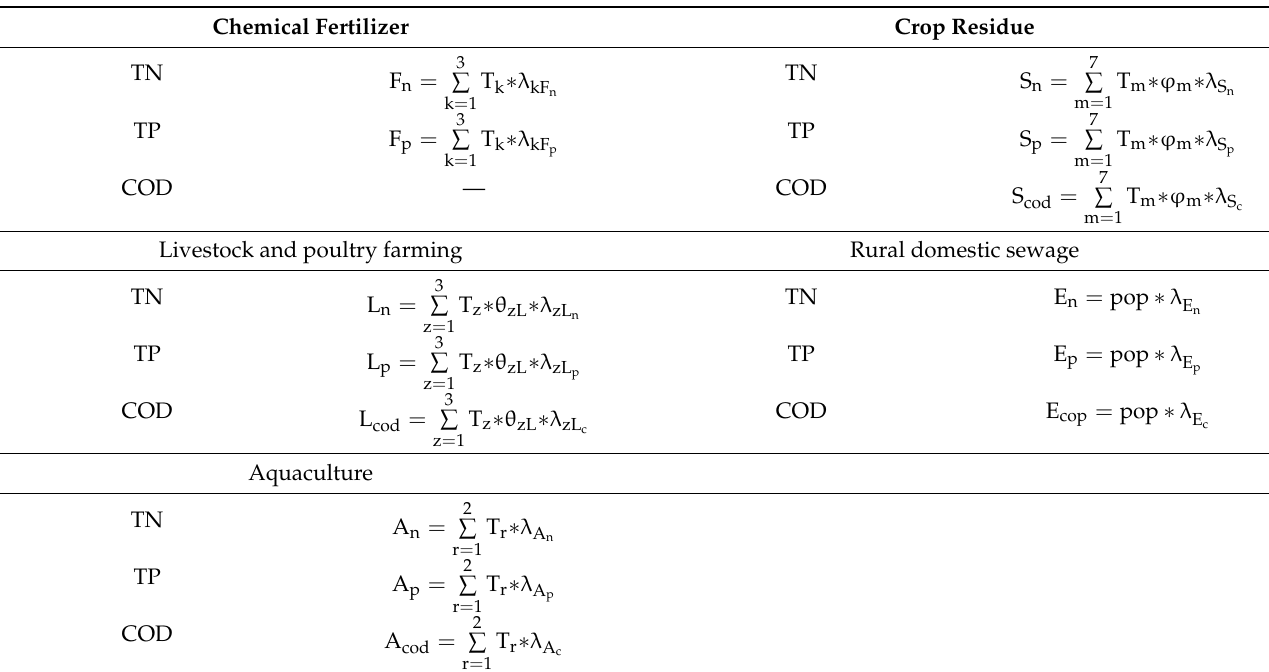
Table 2. Equations for Calculating ANPS